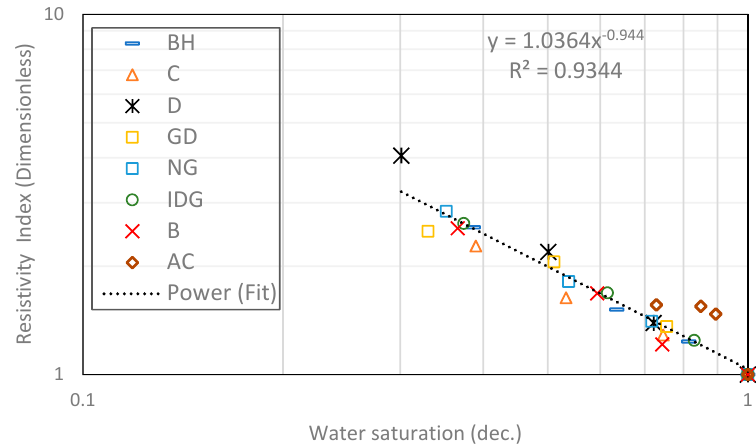
Figure 6. Power-law relationship between rock electrical resistivity and water saturation in a foam-water system.